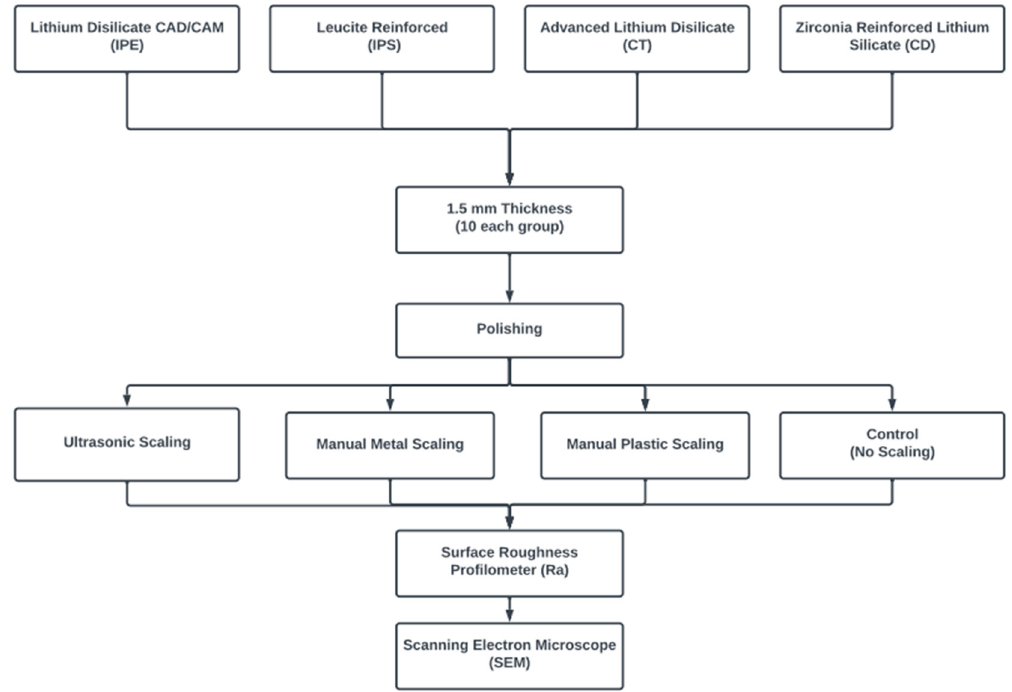
Figure 1. Study design flowchart.